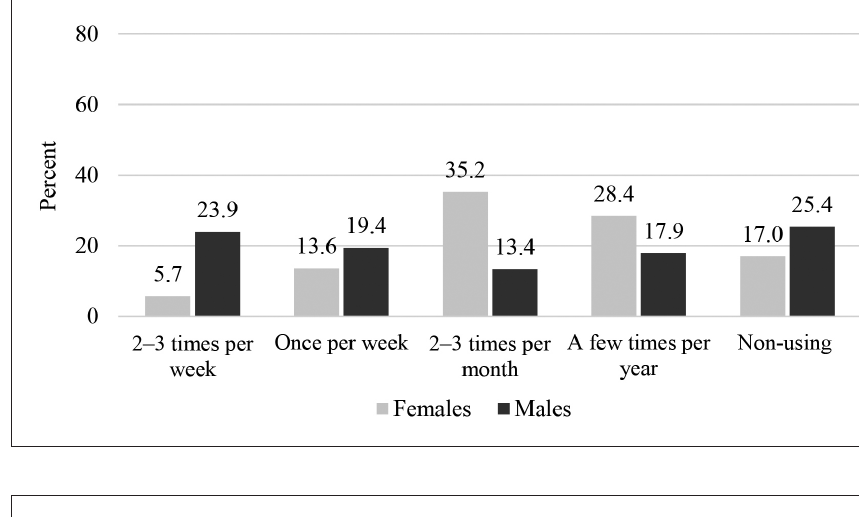
Figure 8. Frequency of wine con- sumption